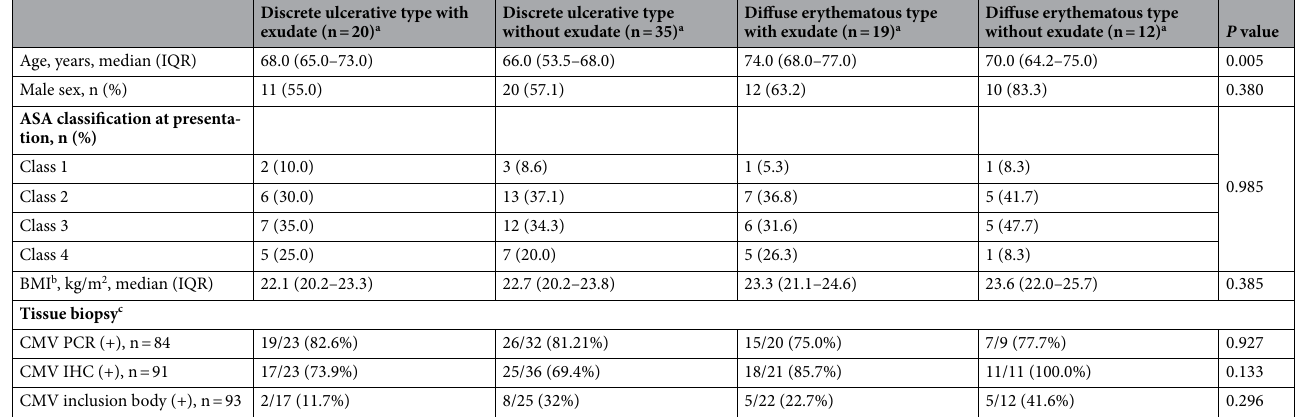
Table 3. Clinical characteristics of cytomegalovirus gastroenterocolitis according to endoscopic types. CMV, cytomegalovirus; IQR, interquartile range; ASA, American Society of Anesthesiologists; BMI, body mass index; PCR, polymerase chain reaction; IHC, immunohistochemistry. a The endoscopic types of patients were defined according to the main involved location. b BMI data were not available for 2 of the 86 patients. c The number of tissue biopsy results were based not on the number of patients but on the number of involved gastrointestinal